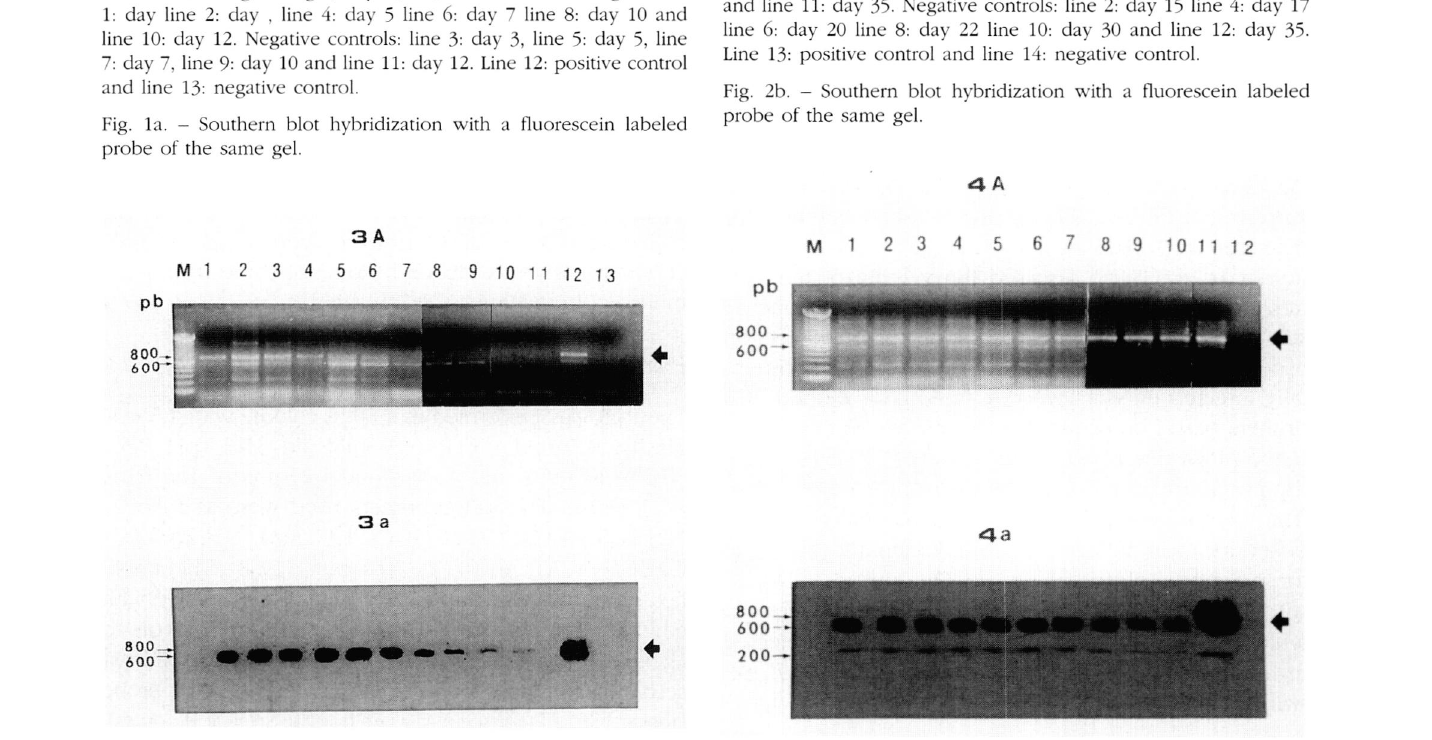
Fig. 1A. T. spiralis: - PCR products were analysed by electropho resis in 1.5 % agarose gel, days (0-12). M: Molecular weight. Line